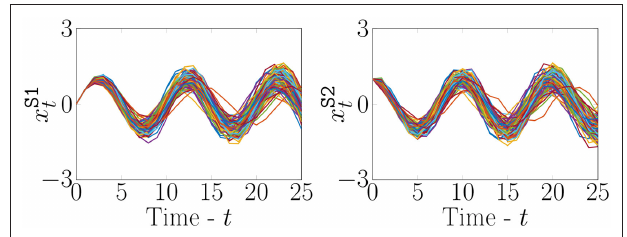
FIGURE 1 | Examples of realizations of x S for a Fourier Form process with parameters σ S w = 0.01 and p =